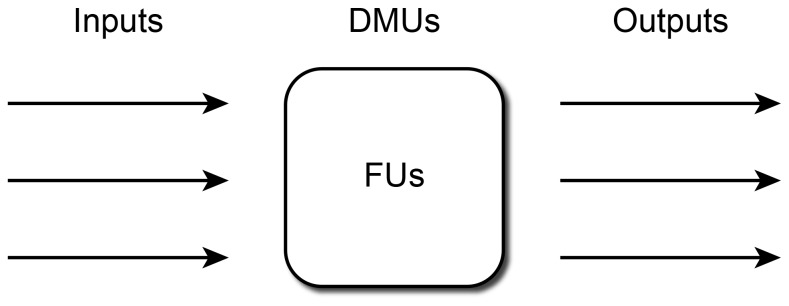
Illustration of DEA.